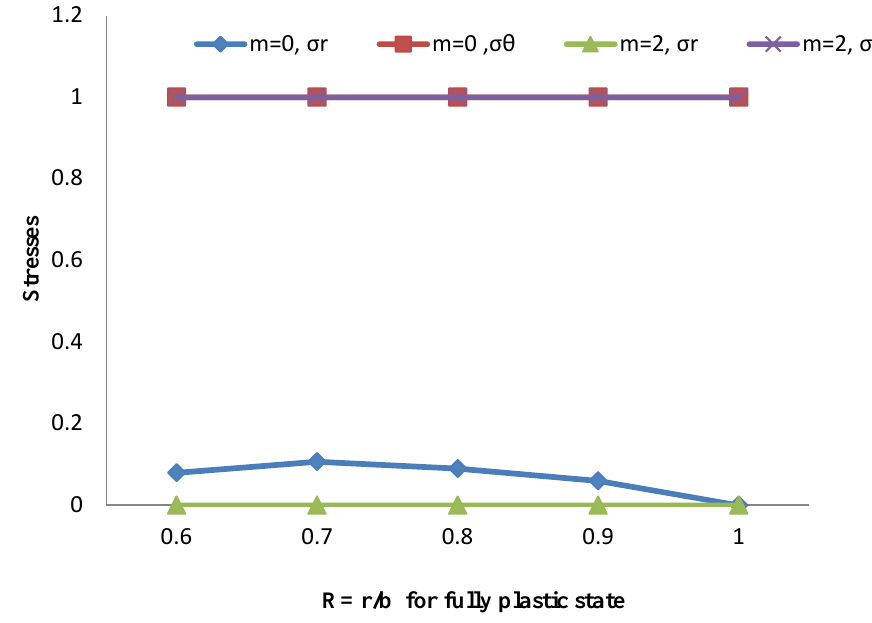
Figure6. Stress distribution with respect to radii ratio R = r/b for C =